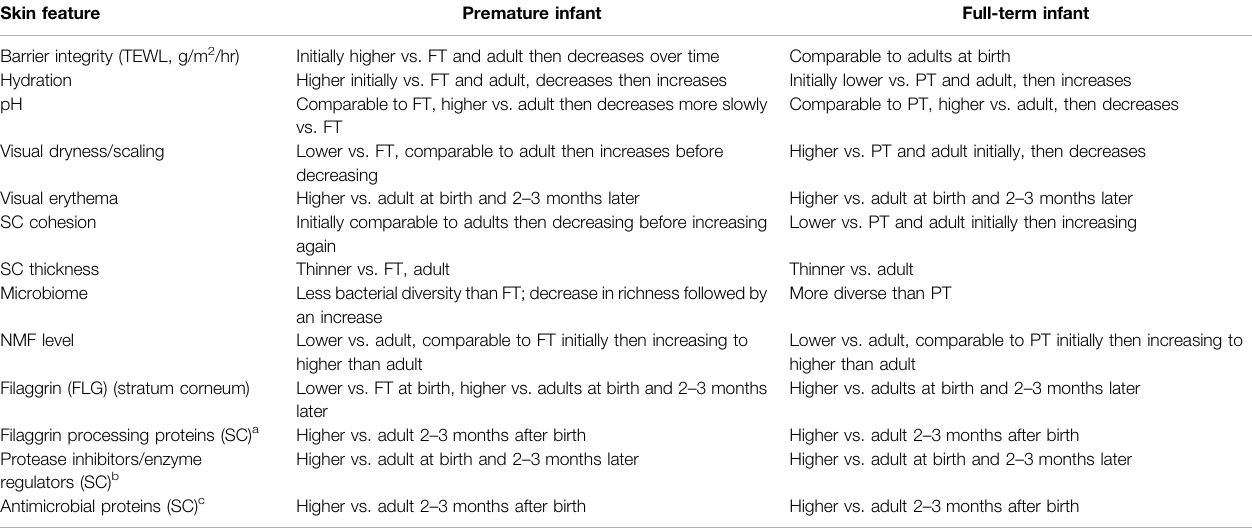
TABLE 3 | Overview of the most important features of premature and full-term infants at birth and over the fi rst few postnatal months relative to the benchmark of normal, healthy adult skin. Skin feature Premature